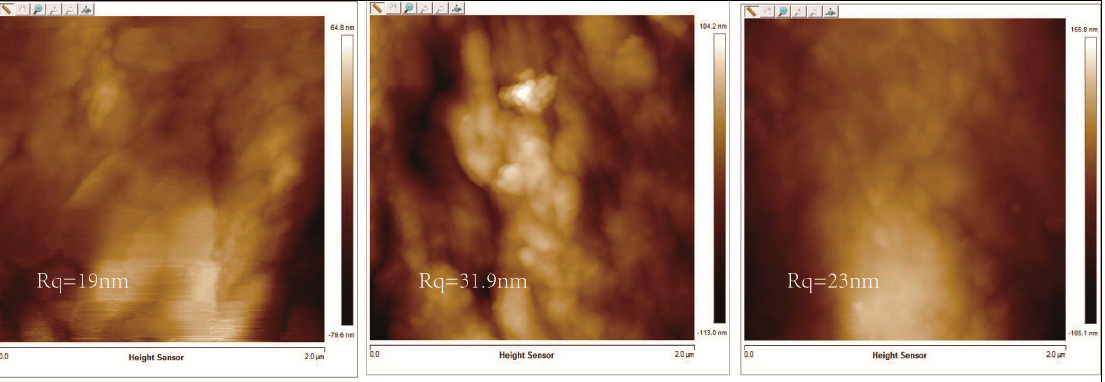
Figure 4. Scanning Electron Microscopy (SEM) images of thermo-treated cherry wood: ( a ) untreated, ( b ) nitrogen plasma treated, and ( c ) oxygen plasma treated.